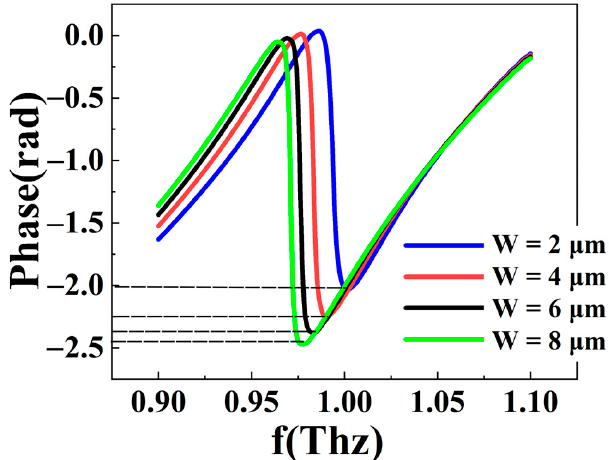
Figure 6. Effect of Cu line width on phase delay and resonance frequency.